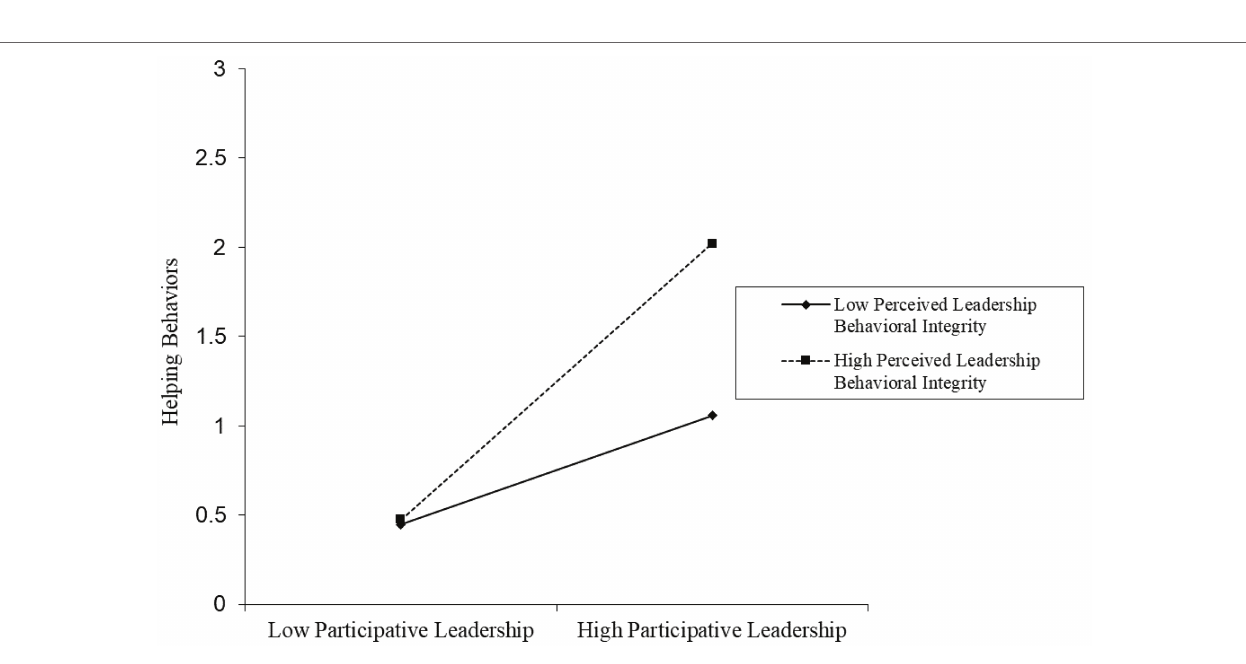
FIGURE 3 | Moderating effect of perceived leadership behavioral integrity between participative leadership and helping